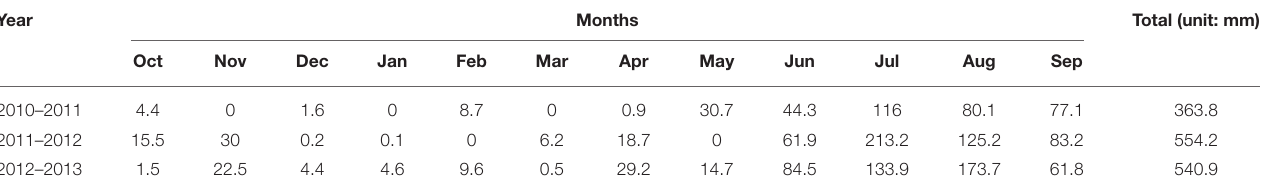
TABLE 1 | Rainfall throughout the wheat and maize cropping periods from 2010–2011 to 2012–2013, at Luancheng Agro-Ecosystem Experimental Station